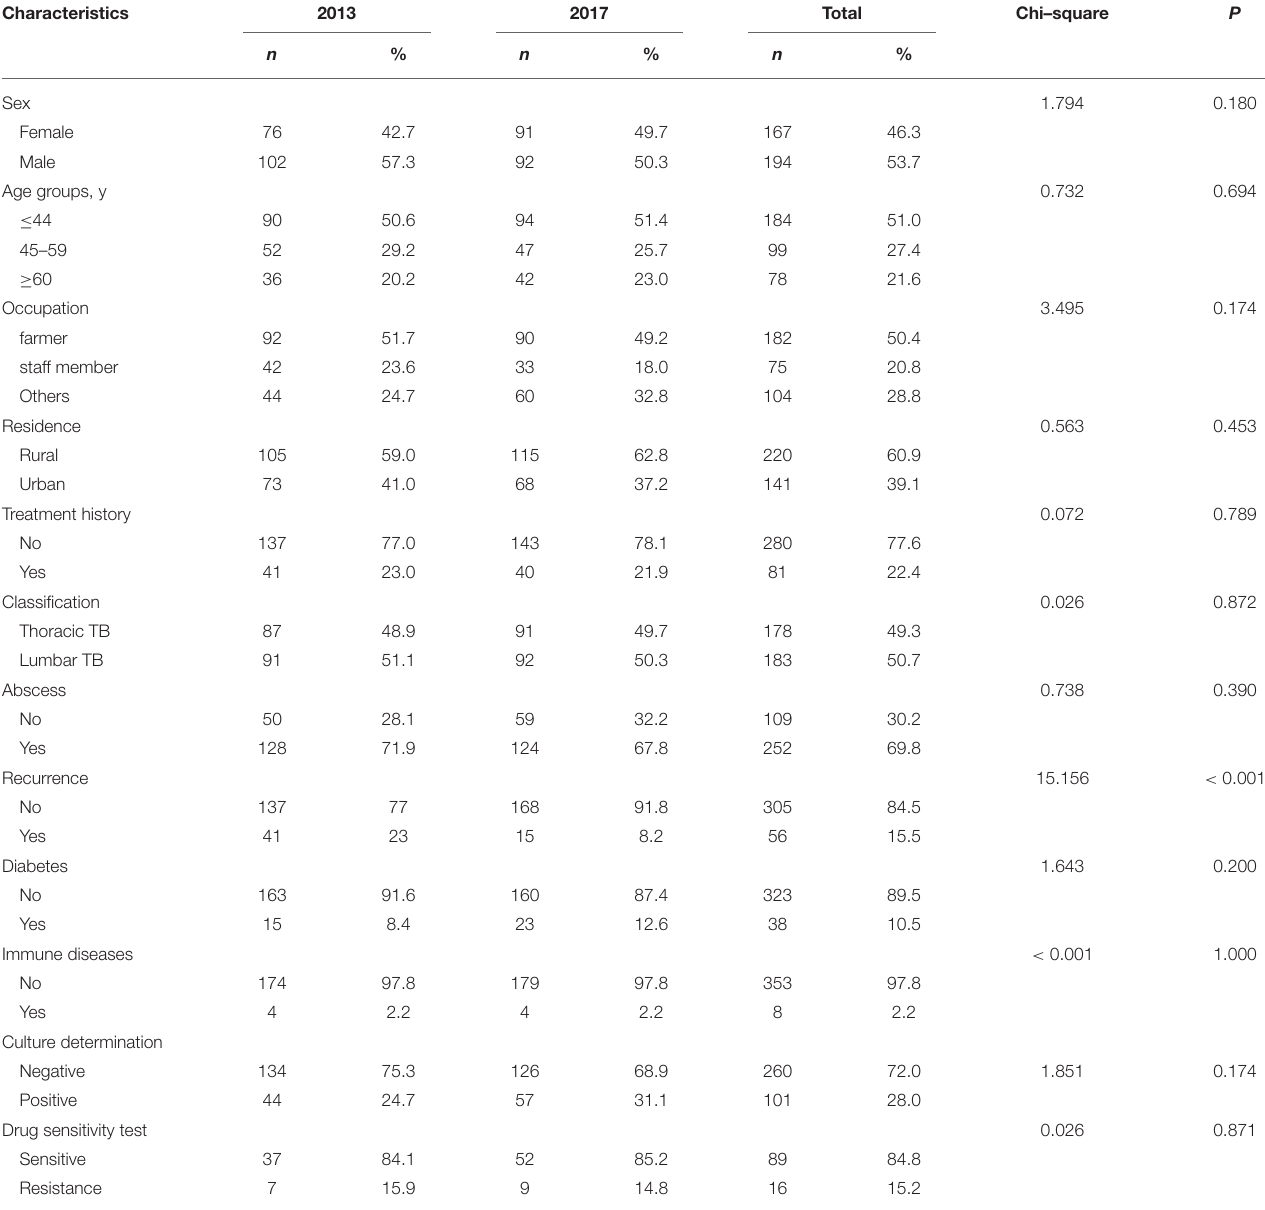
TABLE 1 | Demographic and clinical characteristics of 2013 and